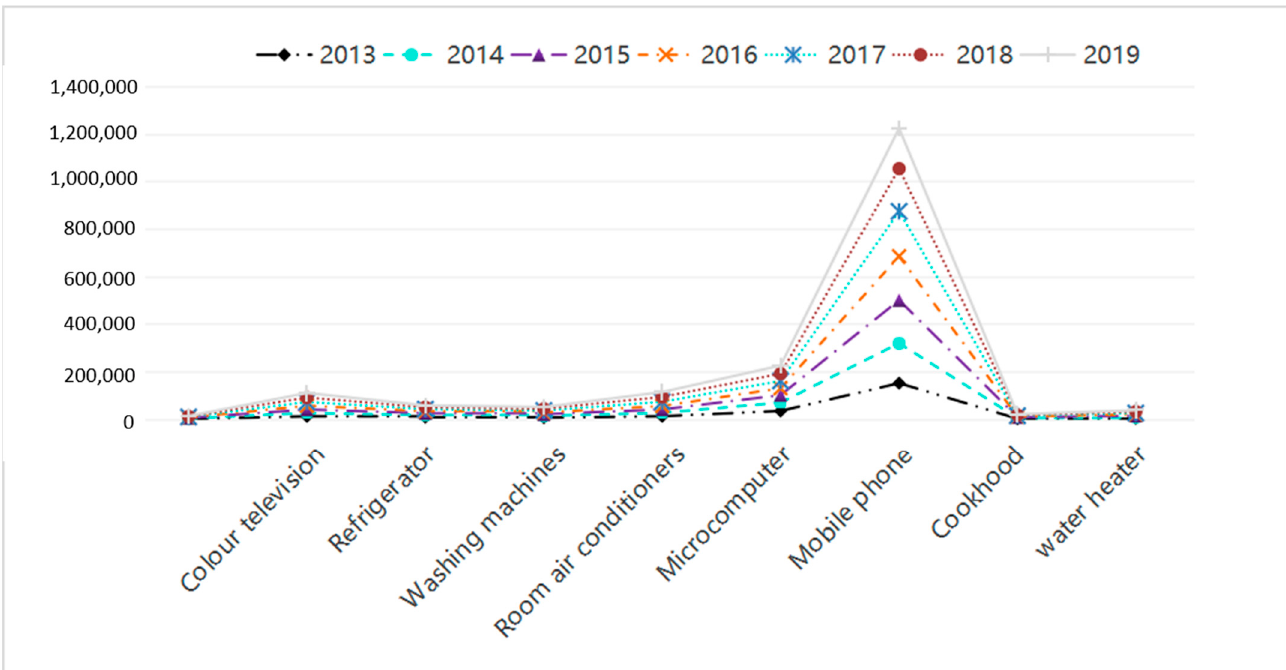
Figure 5. Household output of electrical and electronic equipment (EEE) in China (10,000 units).